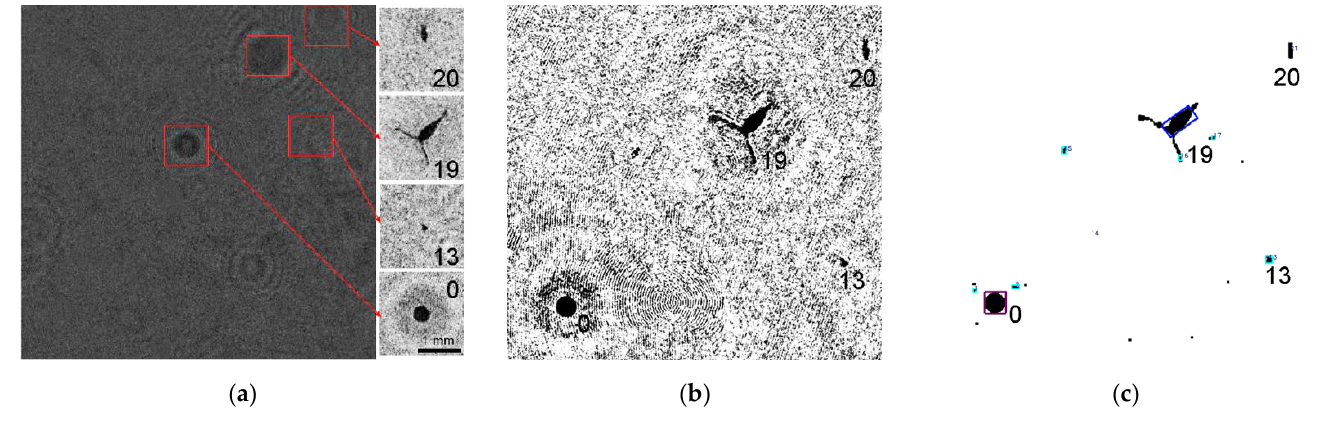
belonging to a particular